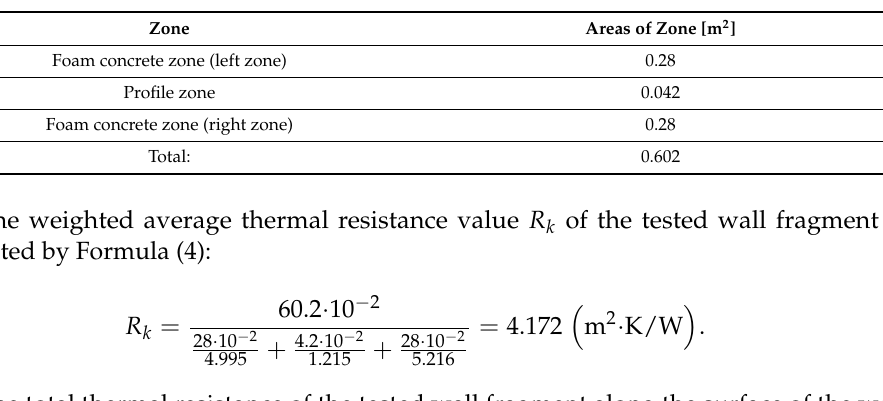
Table 6. Areas of characteristic zones of the wall